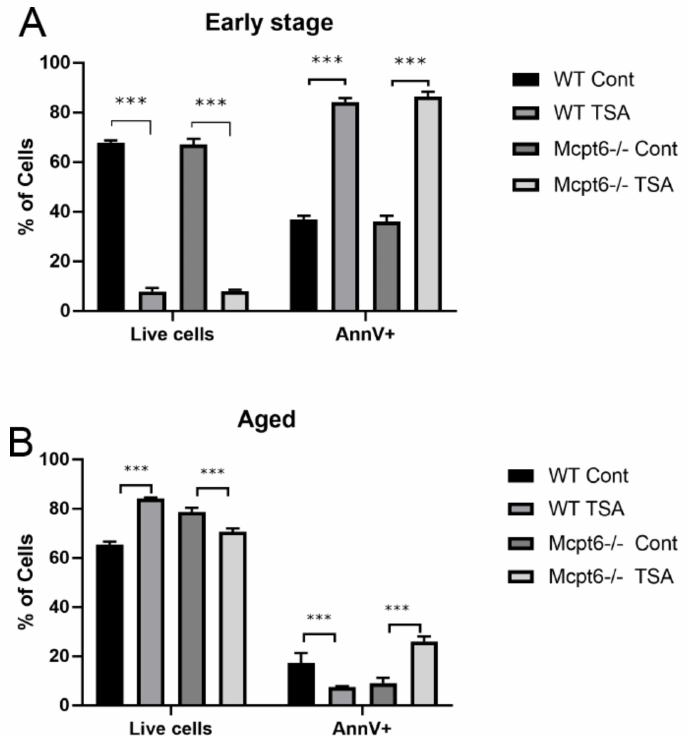
Figure 2. The absence of tryptase Mcpt6 a ff ects the sensitivity to trichostatin A (TSA) in aged MCs. Early stage ( A ) and aged ( B ) MCs were treated with non-toxic concentrations of Trichostatin A (TSA) for extended periods of time (14 days), with repeated addition of TSA on every 4th day. The cells were stained and analyzed using flow cytometry for apoptotic markers. Note that the early stage WT and Mcpt6 − / − MCs were equally sensitive to TSA, whereas only Mcpt6 − / − aged cells showed reduced viability in response to TSA. Data are presented as mean values ± SEM, pooled from three di ff erent experiments, analyzed with Sidaks multiple comparison test or by Two-way ANOVA. **** p ≤ 0.0001, ** p < 0.005. Cont, vehicle